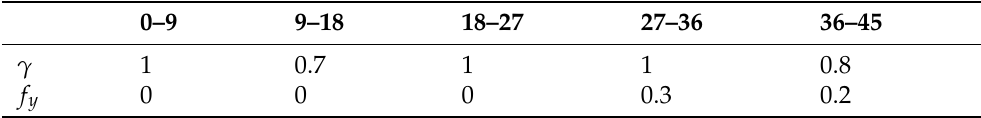
Table 3. Sensor faults applied in q 1 for the faulty scenarios.